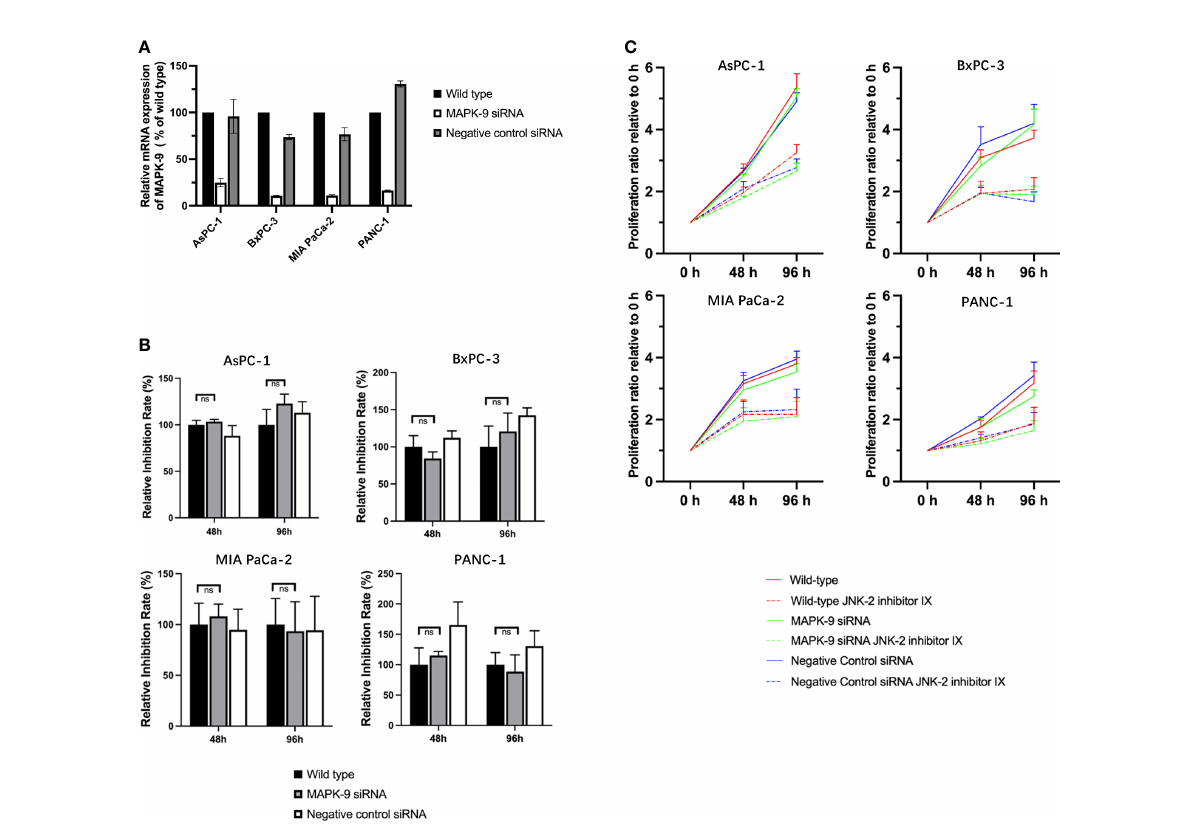
FIGURE 7 siRNA mediated knockdown of JNK2 does not impact the effect of JNK-in-IX in pancreatic cancer. (A) qPCR analysis revealed that siRNA targeting MAPK-9/JNK2 effectively reduces the expression of MAPK-9. Results are shown as means of two replicates in qPCR. (B) Quantitative inhibition rate. 2x10 4 /ml of wildtype, control transfected and knockdown pancreatic cancer cells were seeded in quintuplicate into each well of a 384-well plate containing 50 µl of complete medium. JNK-in-IX was added after 24 h with the before mentioned concentrations. Cell viability was measured by CTG after 48 h and 96 h after treatment. The results presented demonstrate the effect of JNK-in-IX on wildtype cells, JNK2 knockdown cells and negative control cells respectively. 100% equals the inhibition rate of wildtype cells at each timepoint. This demonstrates that JNK-in-IX is equally effective irrespective of JNK2 expression. (C) Cell growth with or without JNK-in-IX. JNK-in-IX suppressed cell growth after 48 h and 96 h after treatment. Results are shown as proliferation ratio relative to 0 h after JNK-in-IX was added. ns p